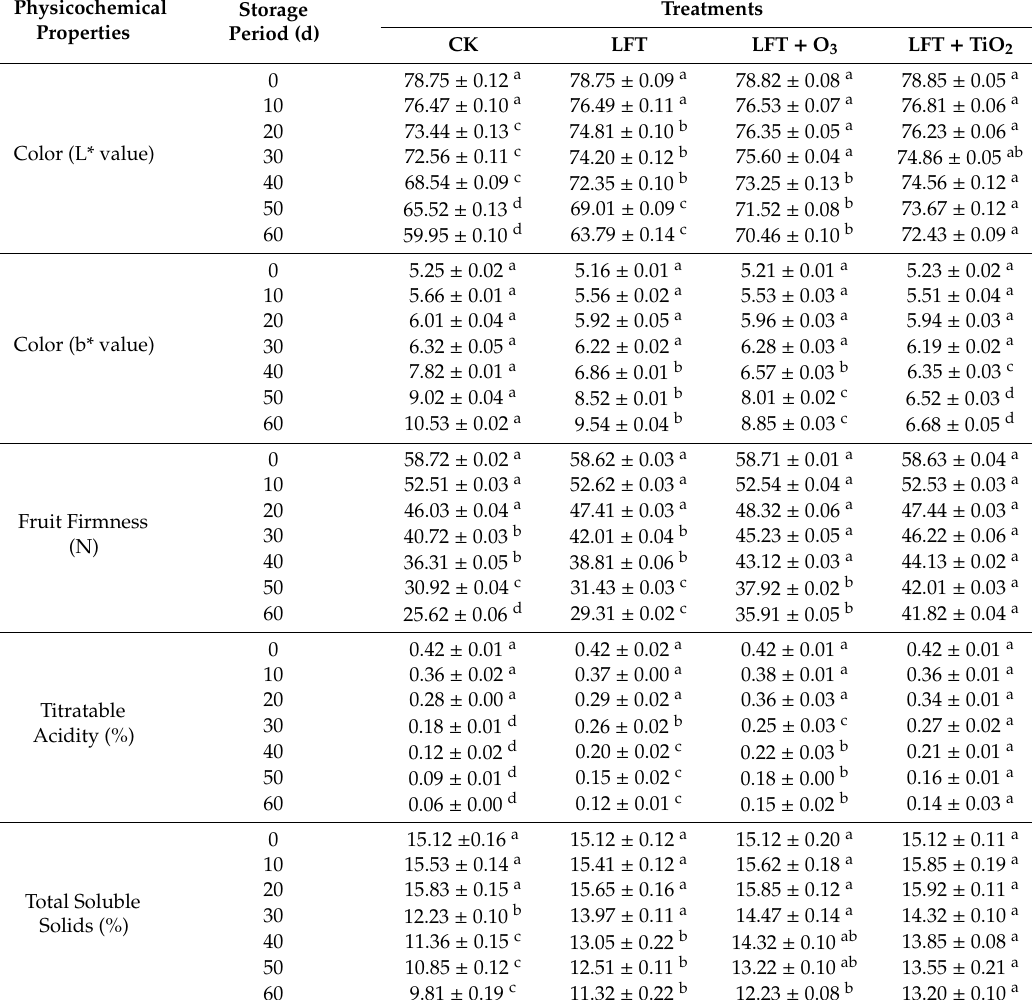
Table 1. Changes of physicochemical properties of di ff erent treatments after 60 d